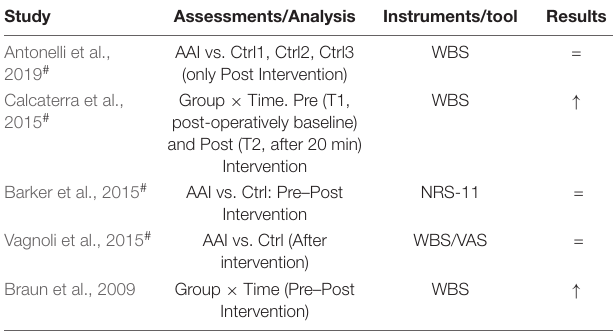
TABLE 4A | Effect of AAI on pain (controlled studies).